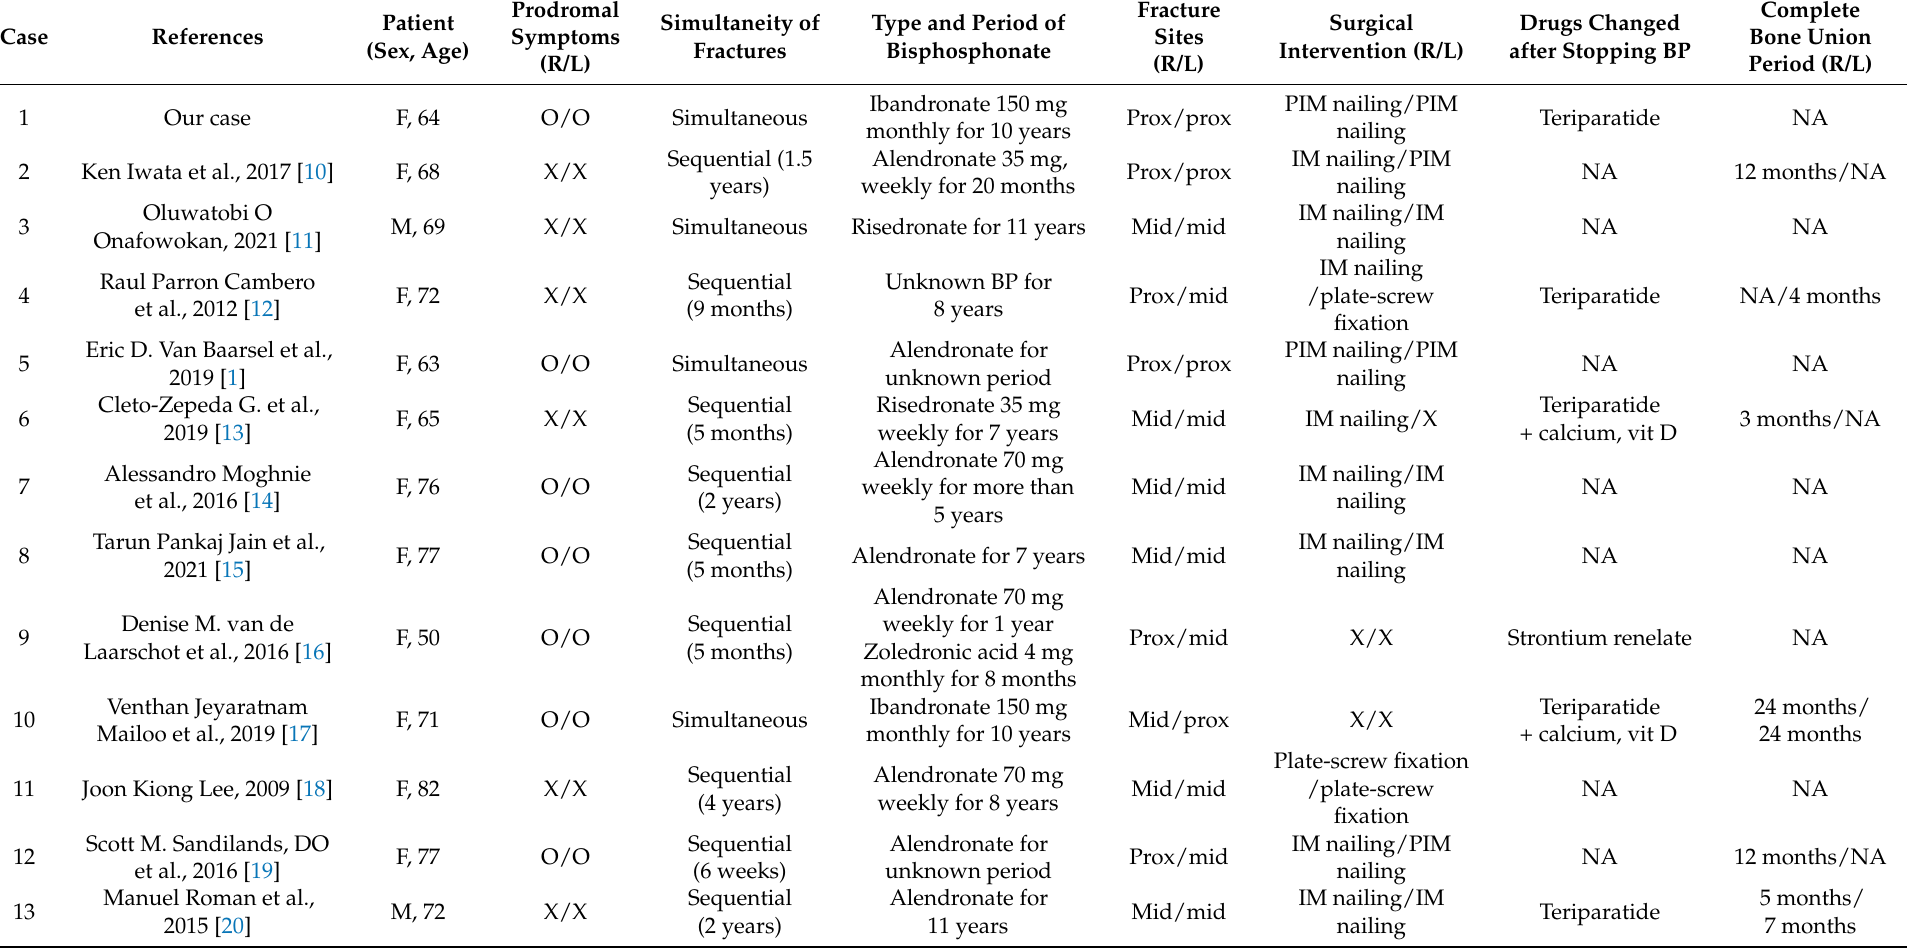
Table 1. Data of 43 patients with bilateral AFF treated with BP for osteoporosis in 39